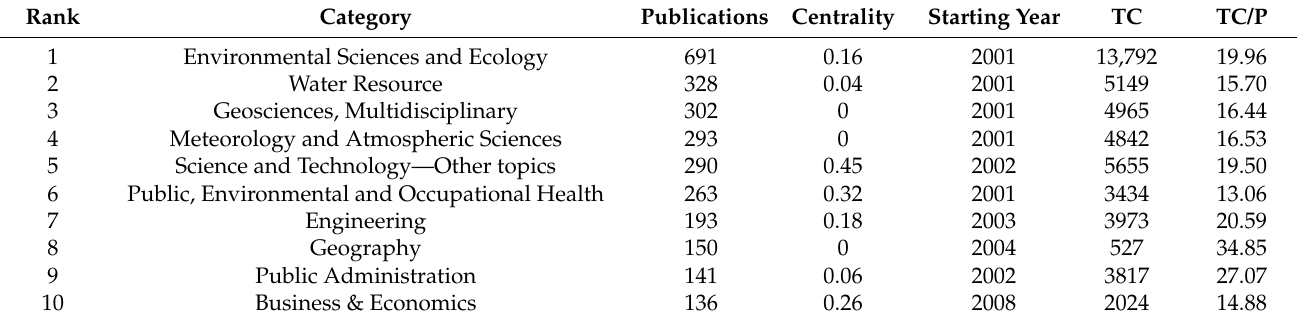
Table 3. Top 10 categories in community resilience research from 2001 to